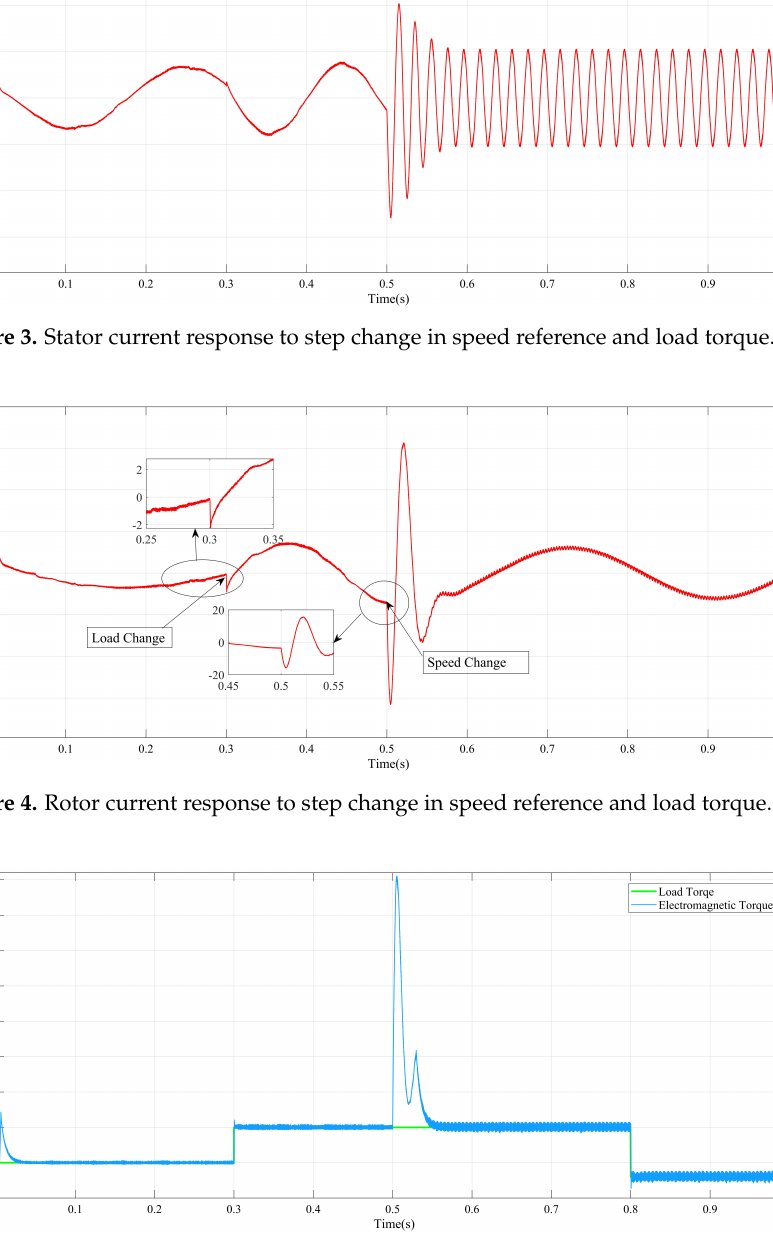
Figure 5. Electromagnetic torque response to step change in speed and load